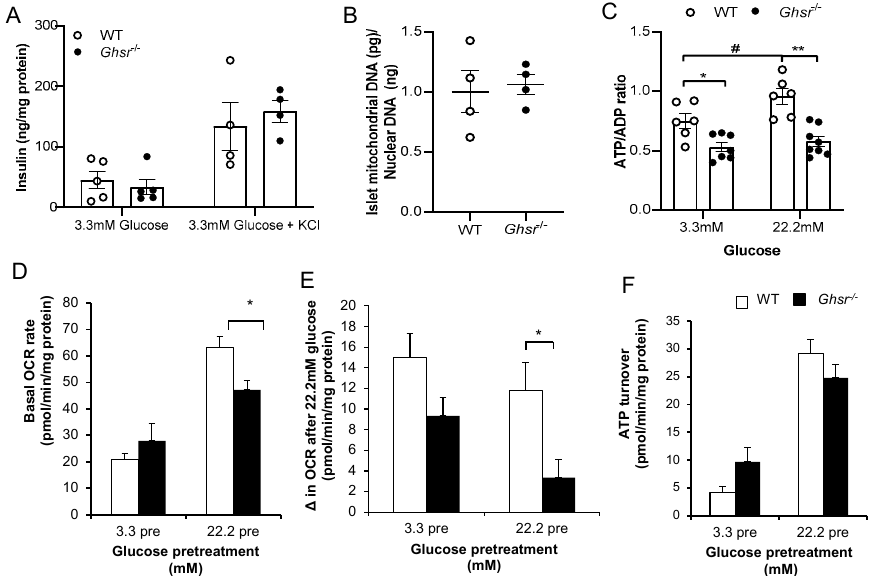
Figure 2. Ghsr − / − islets have a lower ATP/ADP ratio. ( A ) Islets from WT and Ghsr − / − mice were treated with 3.3 mM glucose in the presence or absence of 30 mM KCl, and insulin was measured after 2 h. Insulin was normalized to total protein content in islets, n = 4–5. ( B ) Ratio of mitochondrial DNA to nuclear DNA content in islets. n = 4. ( C ) 15 Islets/well from WT and Ghsr − / − mice were treated with 3.3 or 22.2 mM glucose for 2 h, and then the ATP/ADP ratio was measured, n = 6–8. ( D ) OCR was assessed in islets of WT and Ghsr − / − mice. Islets of WT and Ghsr − / − mice were pretreated with 3.3 or 22.2 mM glucose for 2 h, and then the basal OCR rate was measured. ( E ) Change in OCR from baseline after 22.2 mM glucose treatment. ( F ) ATP turnover, n = 3–5. * p < 0.05, WT vs. Ghsr − / − ; ** p < 0.001, WT vs. Ghsr − / − ; # p < 0.05, 3.3 mM glucose vs. 22.2 mM glucose (WT). To determine why mitochondrial function was altered, we further assessed the OCR of islets pretreated with either low glucose (3.3 mM) or high glucose (22.2 mM). As ex- pected, islets treated with low glucose had a much lower basal OCR compared to islets treated with high glucose. The basal OCR of the Ghsr − / − islets treated with high glucose for 2 h was significantly lower than the WT islets treated with high glucose (Figure 2D). Upon further stimulation by glucose (22.2 mM), we observed strikingly reduced OCR in Ghsr − / − islets pretreated with high glucose (Figure 2E). ATP turnover showed a trend of decrease in the Ghsr − / − islets pretreated with 22.2 mM glucose but failed to reach statistical signifi- cance (Figure 2F). Together these findings suggest lower availability of substrates in the mitochondria of Ghsr − / − islets, which may contribute to reduced ATP generation. 3.3. Glucose Uptake Is Reduced in Ghsr-Ablated Islets GLUT2 is the primary glucose transporter in rodent β -cells and plays a crucial role in glucose sensing and uptake [63]. The gene expression of Glut2 was significantly reduced in islets of Ghsr − / − mice (Figure 3A). G6P is known as the first substrate produced after glucose is transported into the β -cells [64]. Consistent with reduced Glut2 expression, we detected reduced G6P content in the pancreas of Ghsr − / − mice (Figure 3B). Our results in- dicate impaired GSIS in Ghsr − / − islets is likely due to reduced uptake of glucose into the cytosol, which produces lower G6P levels, subsequently leading to a lower ATP/ADP ra- tio. The reduced ATP/ADP ratio then triggers insufficient membrane depolarization, which subsequently results in reduced GSIS (Figure 3C).